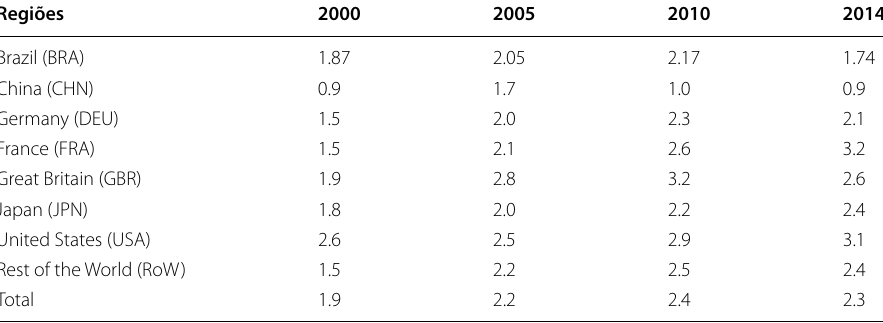
Table 5 Telecommunications’ share in each